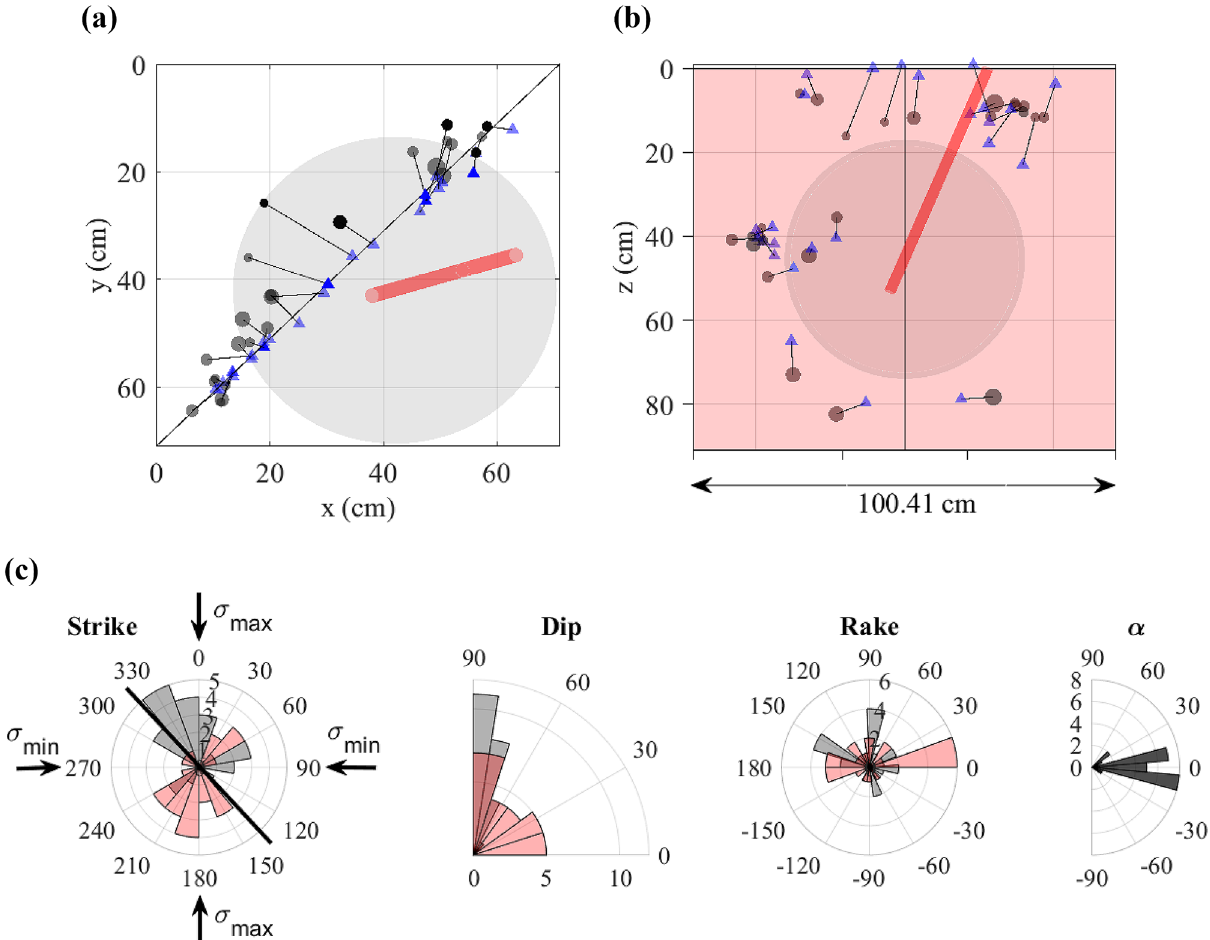
Figure 6. deepCoSeL results for selected real data examples detected in continuous monitoring mode. Views from ( a ) top and ( b ) perpendicular to the artificial cut showing locations from deepCoSeL (circles) and a standard method (triangles). Corresponding events are joined by lines and the size of the circles is relative to the strenght of the detection function. The grey sphere represents the saturated region within the block. ( c ) Fracture angles from the biaxial decomposition of deepCoSeL moment tensor solutions. The orientation of the artificial cut is represented with a thick line over the plot of Strikes. The vertical direction also had applied the same stress as σ min